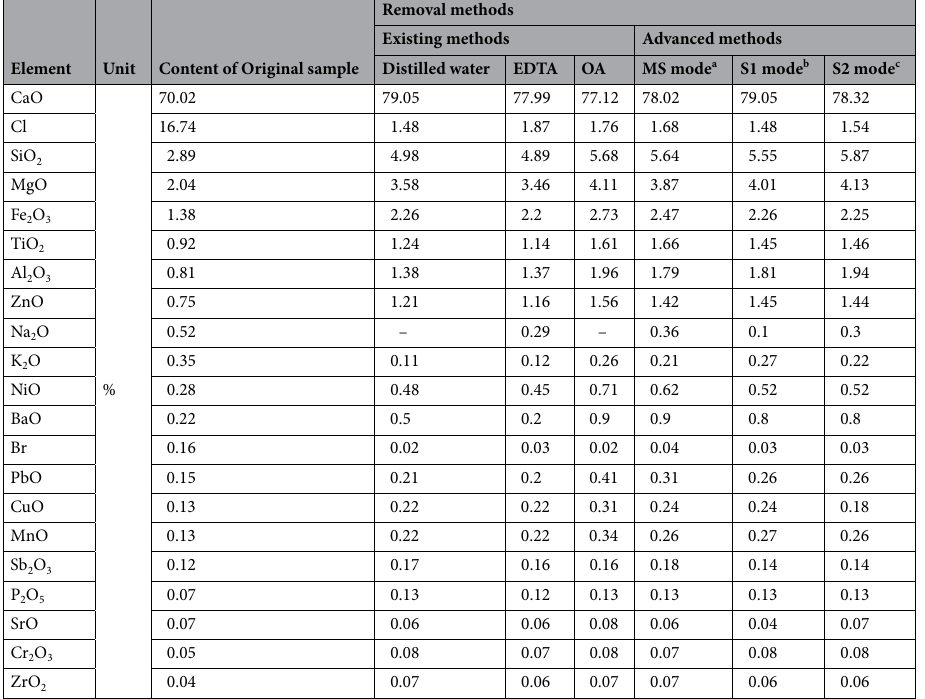
Table 7. The XRF results for the paper incineration ash following removal using various removal methods. a Removal using EDTA and OA simultaneously. b First step: EDTA; second step: OA. c First step: OA; second step: